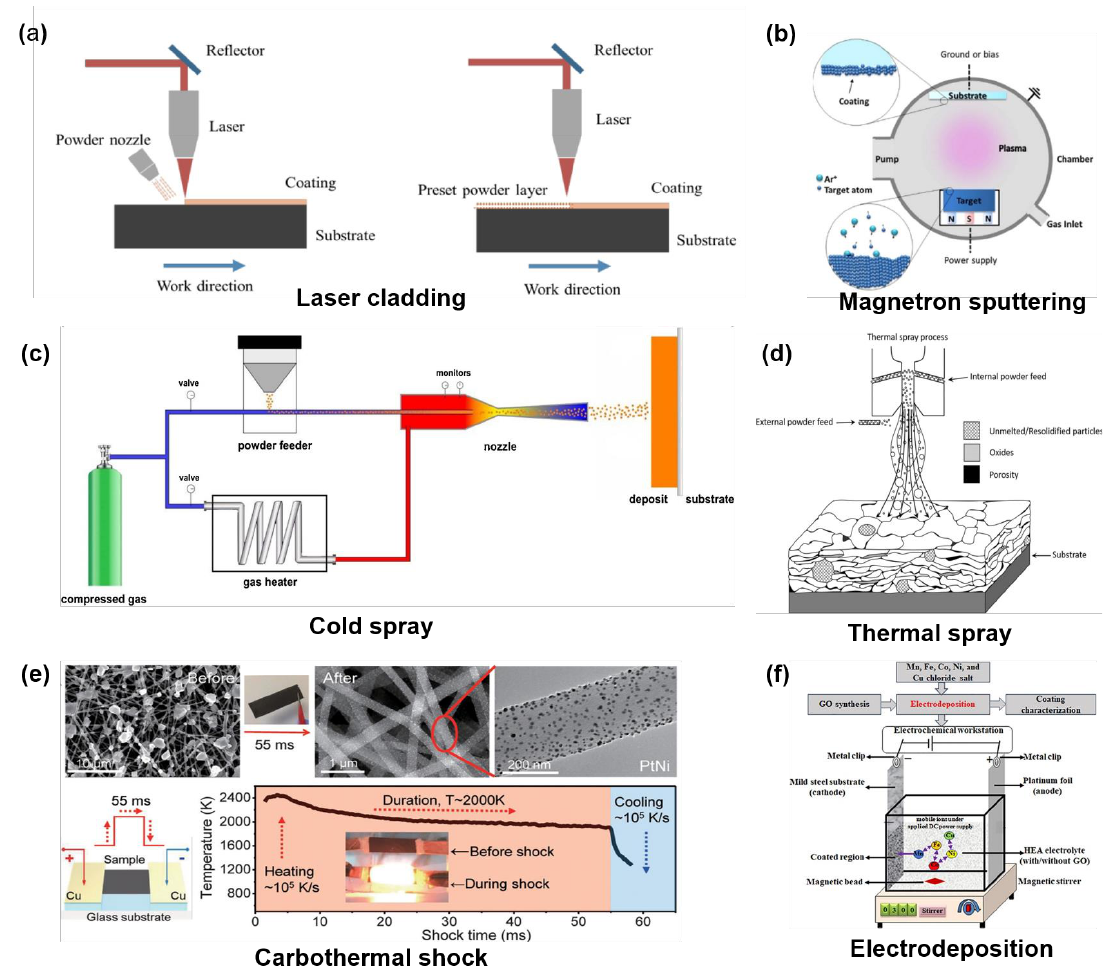
Figure 3. The fabrication methods of HEA coatings. ( a ) Laser cladding [ 50 ] . Copyright 2018